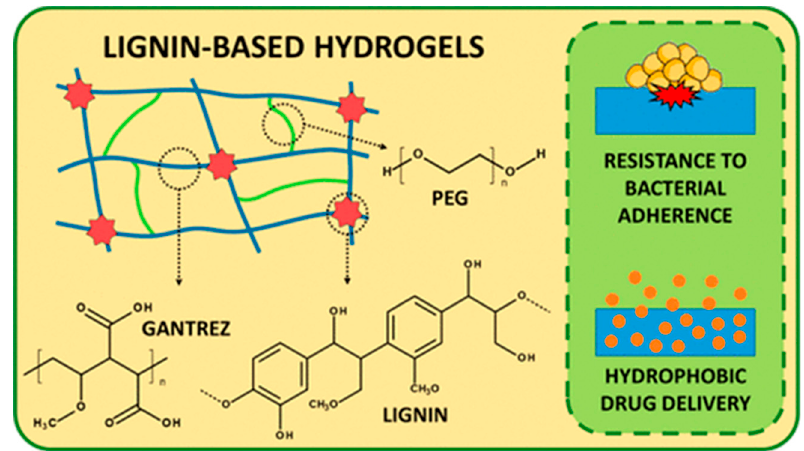
Figure 9. Representation of the synthetic procedure for the preparation of lignin/poly(methyl vinyl ether co-maleic acid) hydrogels crosslinked by PEG. Hydrogels showed diminished bacterial adhesion and capability for the controlled release of hydrophobic drugs. Reproduced with permission from Larrañeta et al. [61]. Copyright © (2019) American Chemical Society.